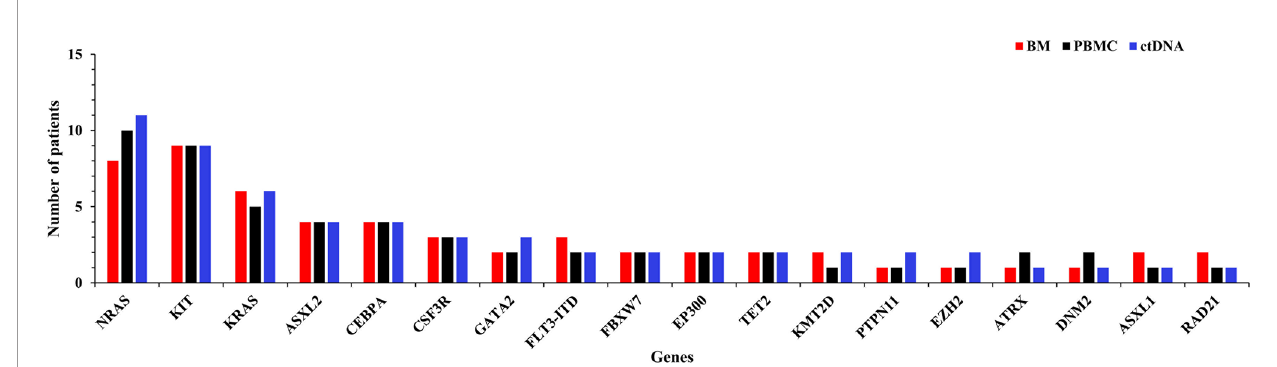
FIGURE 1 | Frequency of AML-related mutated genes as detected by targeted sequencing of bone marrow (BM), peripheral blood mononuclear cell (PBMC), and circulating tumor DNA